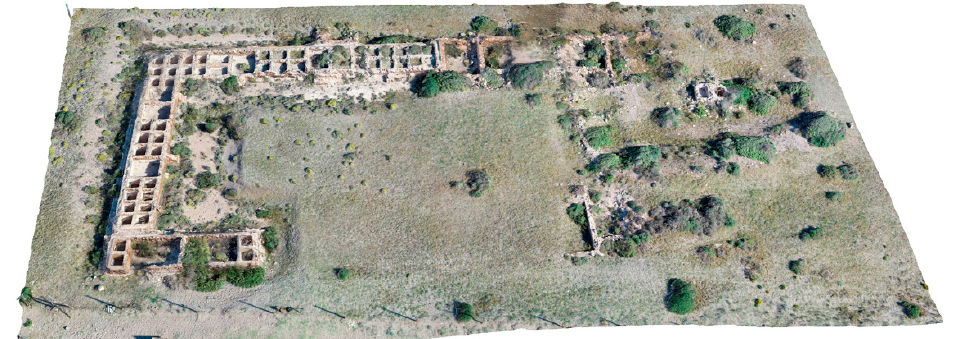
Figure 9. High-resolution model of the officina purpuraria and infectoria.